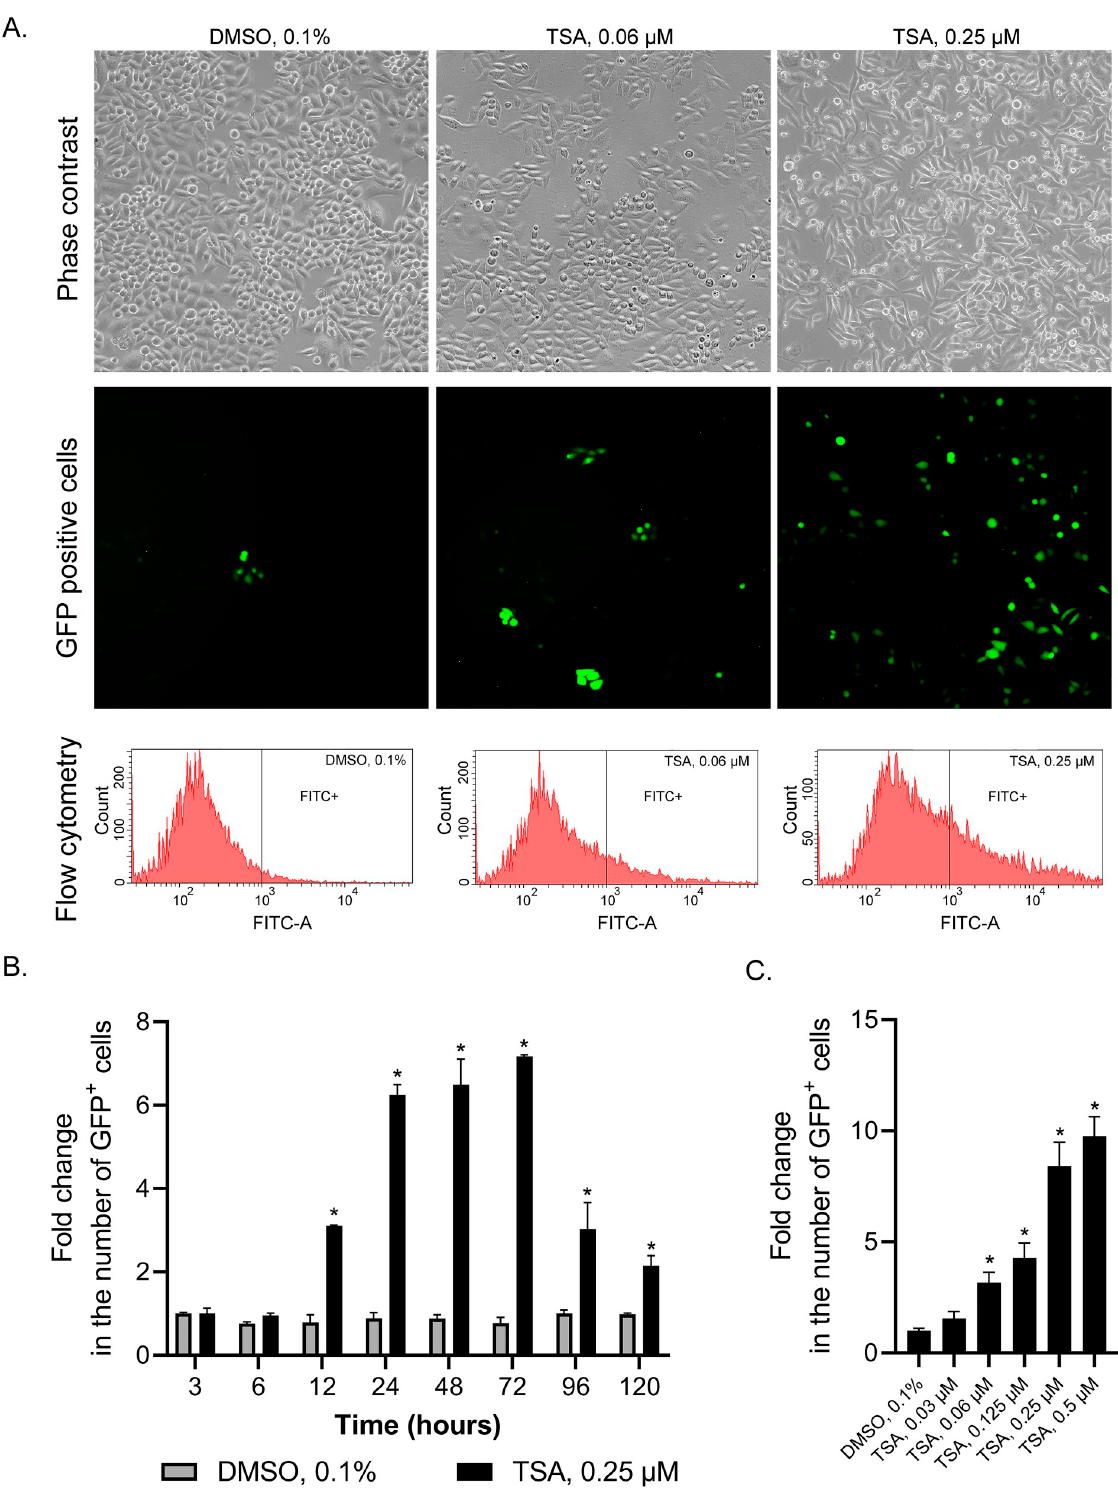
Fig 1. Reactivation of GFP expression in HeLa TI cells by TSA. A. GFP expression in HeLa TI cells depending on the treatment. Cells treated with TSA (0.25 μ M and 0.06 μ M) and DMSO (0.1%) were analyzed with phase-contrast and fluorescent microscopy and flow cytometry. B. Time-response effect of TSA; FACS. C. Dose-response effect of TSA; FACS. The values are expressed as the means ± SD; “ � ” indicates the level of significance to vehicle (p < 0.05).